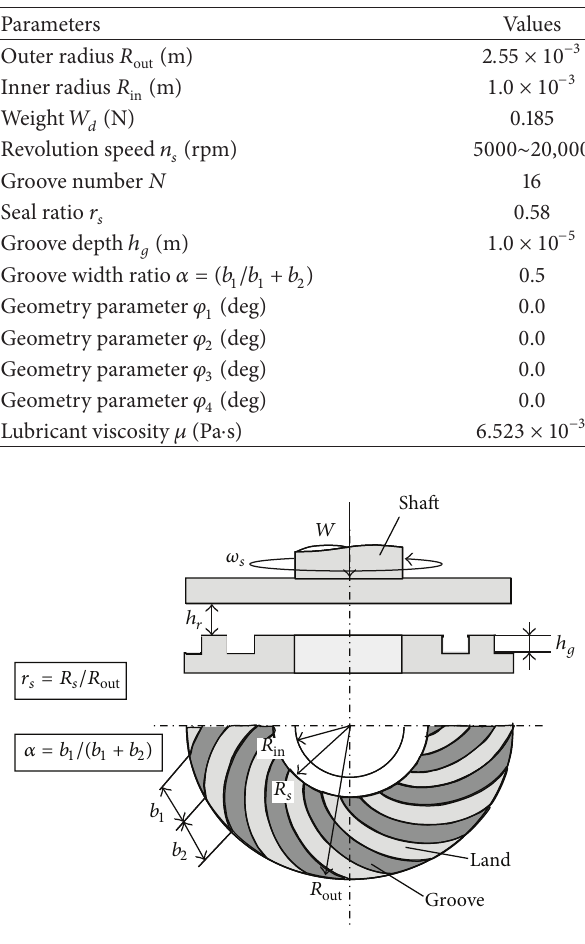
Figure 3: Design parameters for thrust